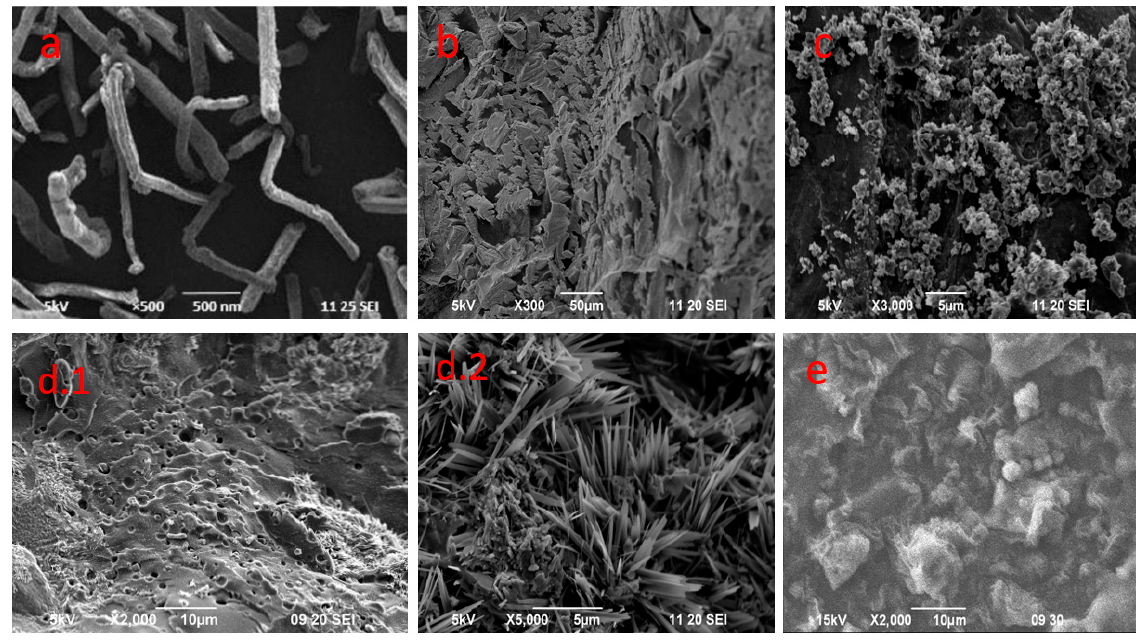
Figure 5. SEM image of ( a ) CNC, ( b ) hydrogel with 0.3% CNC, ( c ) hydrogel with 0.8% CNC, ( d1 ) hydrogel with 1% CNC 2000×, ( d2 ) hydrogel with 1% CNC 5000× and ( e ) gentamicin loaded hydrogel with 1% CNC .